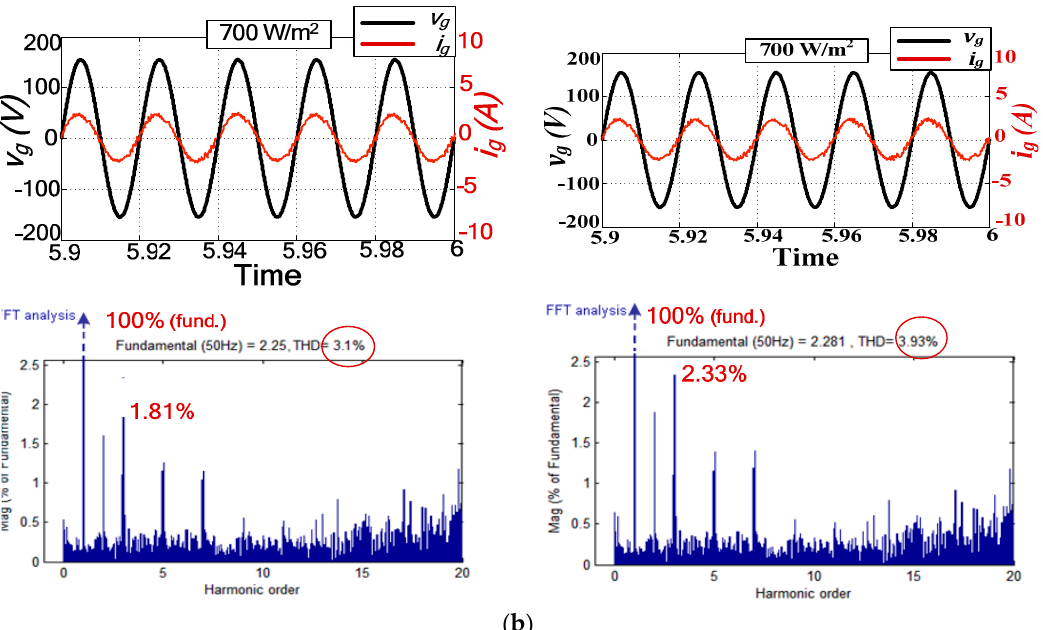
Figure 11. Zoom on PCHC grid current response when applying L dc of 150 mH and 50 mH under irradiance variation: ( a ) high power level, ( b ) low power level.